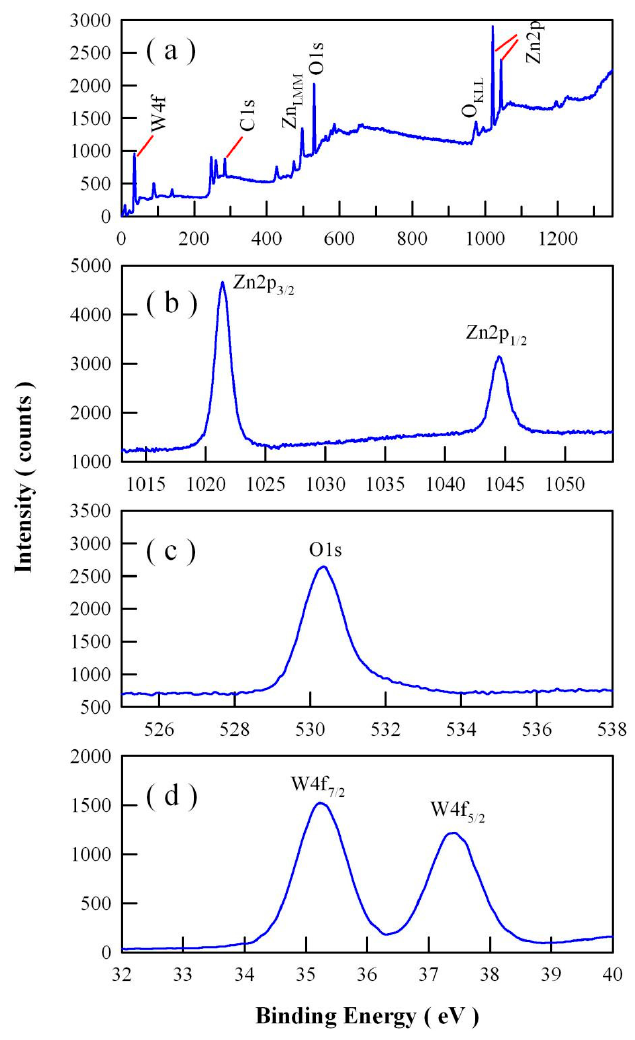
Figure 11. XPS survey scan ( a ), and XPS spectra of Zn 2p ( b ), O 1s ( c ), and W 4f ( d ) in ZnWO 4 nanoplates.